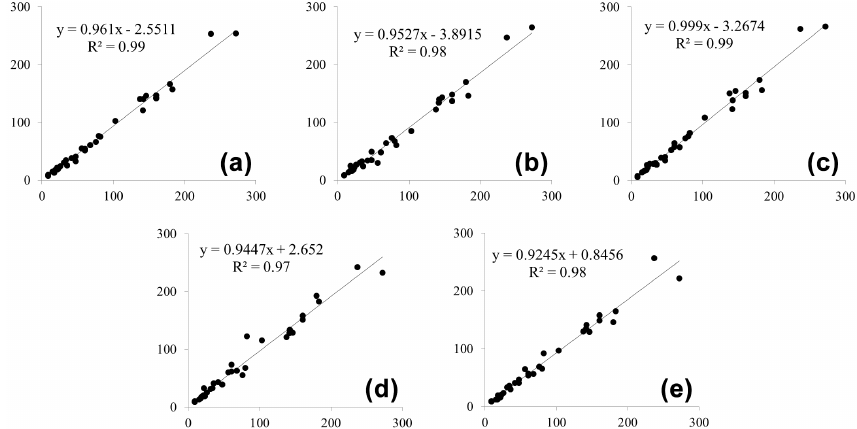
Figure 6. Correlation of PM 2 . 5 between Dongsi station and the other five stations: (a) Dongsi and Tiantan, (b) Dongsi and Guangyuan, (c) Dongsi and Wanshouxigong, (d) Dongsi and Aotizhongxin, (e) Dongsi and Nongzhanguan.